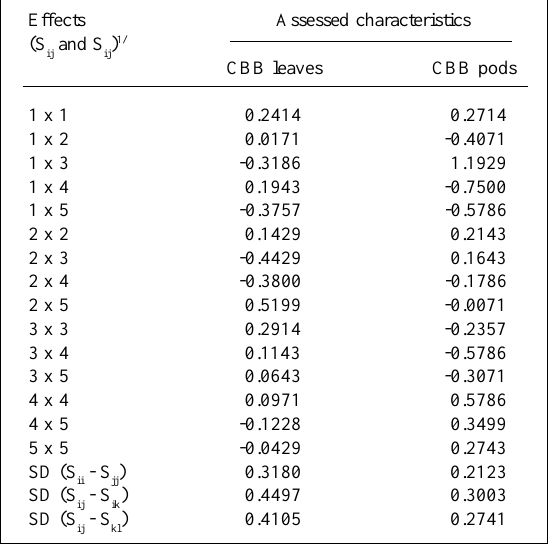
Table V - Estimates of the specific combining ability (s for common bacterial blight (CBB) reaction in leaves and pods of Phaseolus vulgaris L. and the standard deviations (SD) of the effects for two F1, with and without common parents, and between two